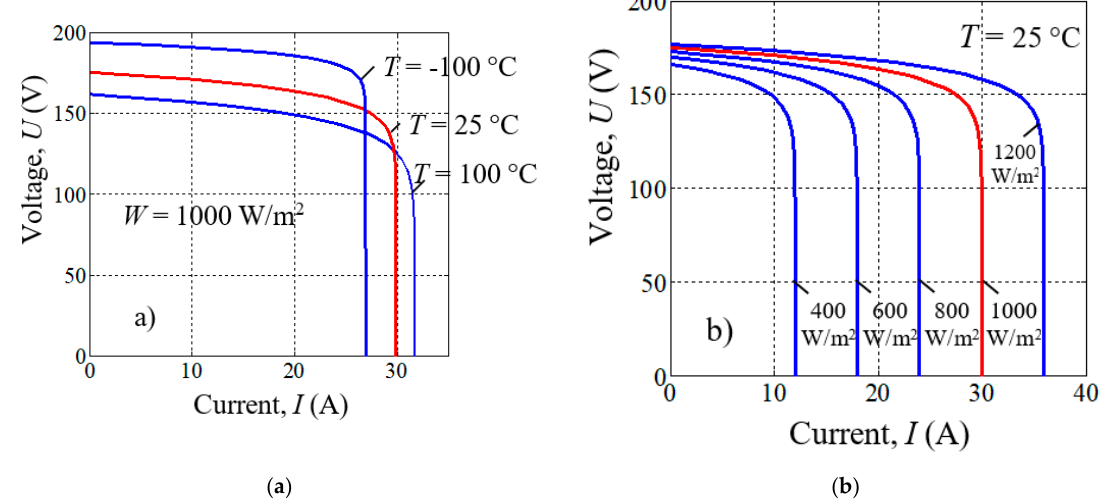
Figure 4. The static characteristics of the solar panel: ( a ) when the temperature T changes; ( b ) when the density of the luminous flux W changes.